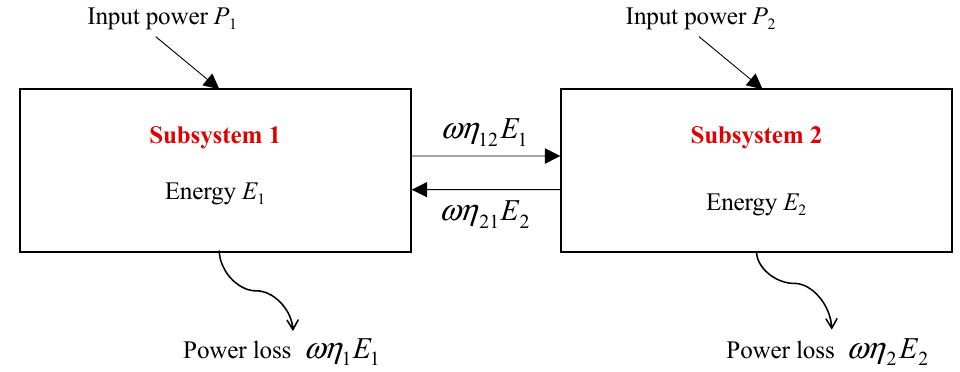
Figure 6. Statistical energy analysis model of two subsystems.